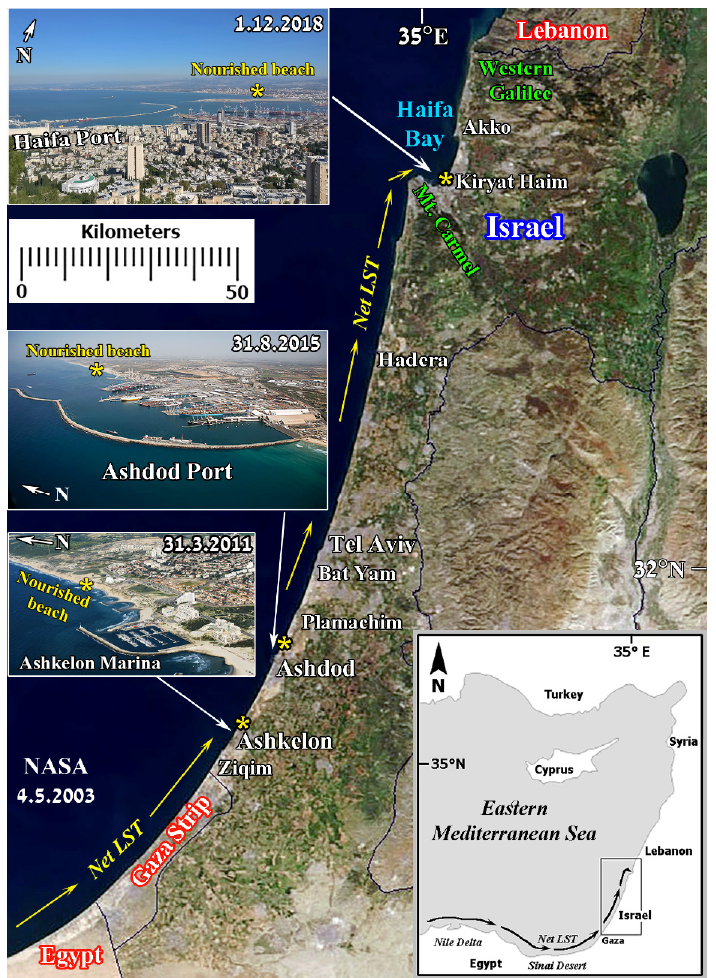
Figure 1. The Mediterranean coast of Israel and the three sites where beach sand nourishment was carried out between 2011 and 2017: south of Haifa Bay (top inset); north of Ashdod Port (central inset); north Ashkelon (bottom inset). Net longshore sand transport direction (yellow arrows). Background: MiddleEast.A2003031.0820.250m.jpg; Photographed by Descloitres, J., MODIS Rapid Response Team, NASA/GSFC, 31.1.2013.